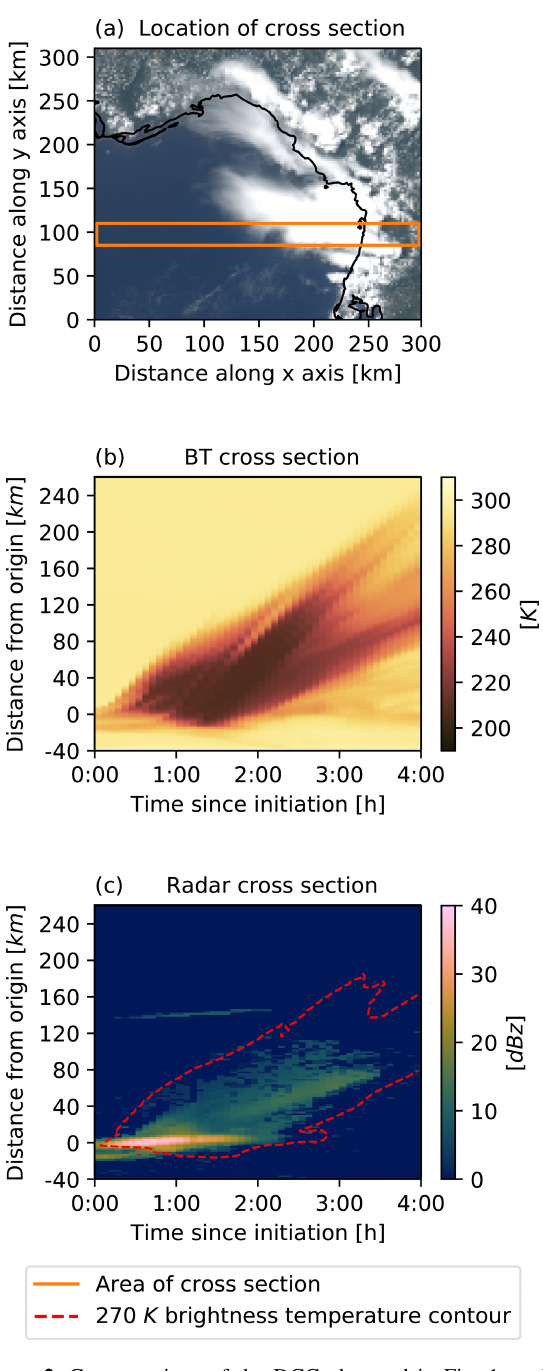
Figure 2. Cross sections of the DCC observed in Fig. 1 as they develop over time. (a) The location of the cross section within the observed DCC. The mean of values is taken in the north-south axis. (b) ABI 10.8µm brightness temperature, showing rapid cooling for the first 30min, followed by an expanding region of anvil cloud that begins to thin and warm after 2–3h. (c) Column mean radar re- flectivity, showing the presence and location of the convective core. Initiation occurred at 82.0 ◦ W 28.5 ◦ N at a time of